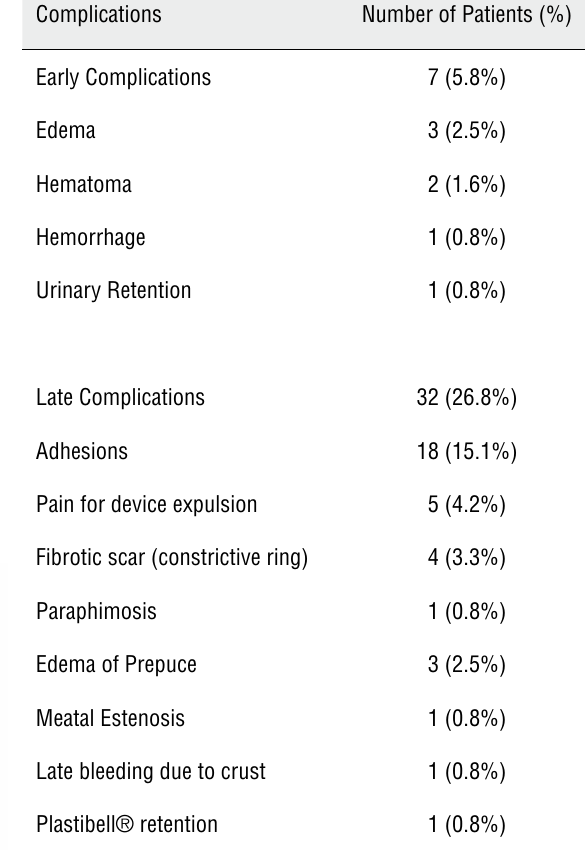
Table 2 - Complications of Plastic Device